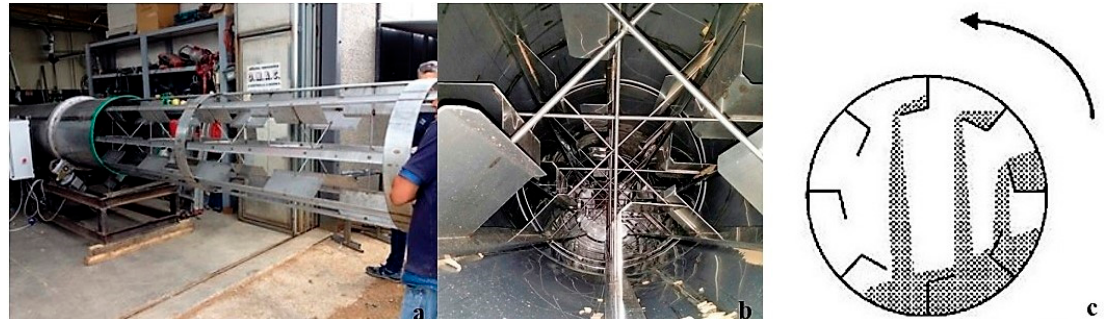
Figure 2. Intertwined flights inside of cylinder ( a , b ); schematic representation of the system ( c ).